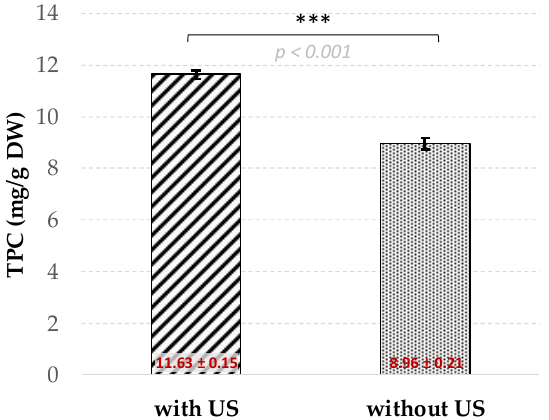
Figure 3. TPC extracted from AOR using the optimal USAE (with US) conditions and comparison with conventional heat reflux method (HRE; without US). Means ± SD standard deviations of three independent extractions; *** significant at p < 0.001.